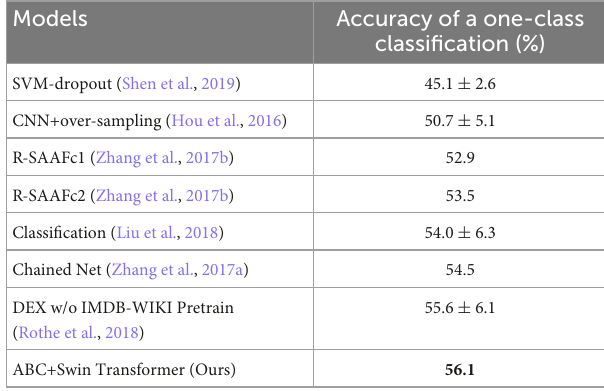
TABLE 3 Comparison of age estimates on the Adience